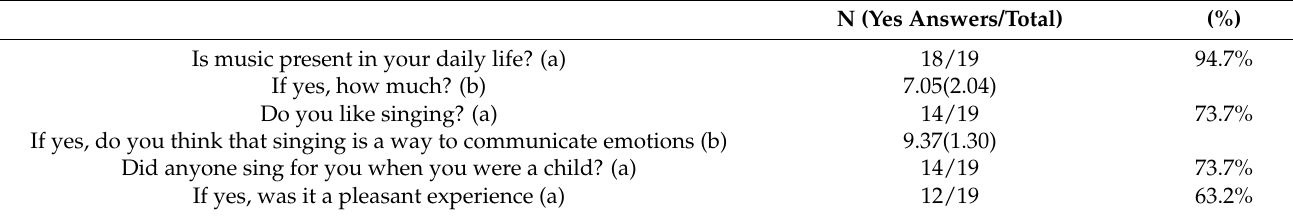
Table 1. Maternal musical